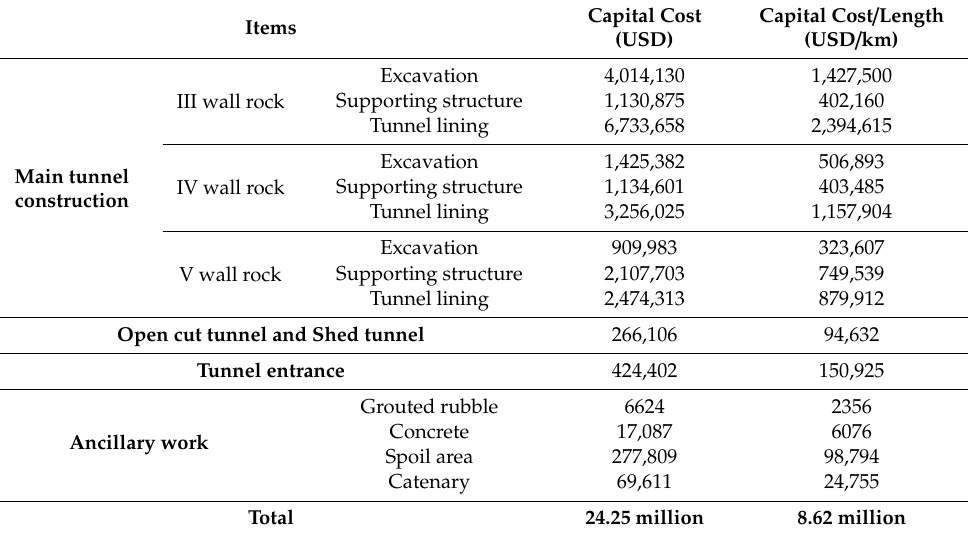
Table 1. Capital costs.